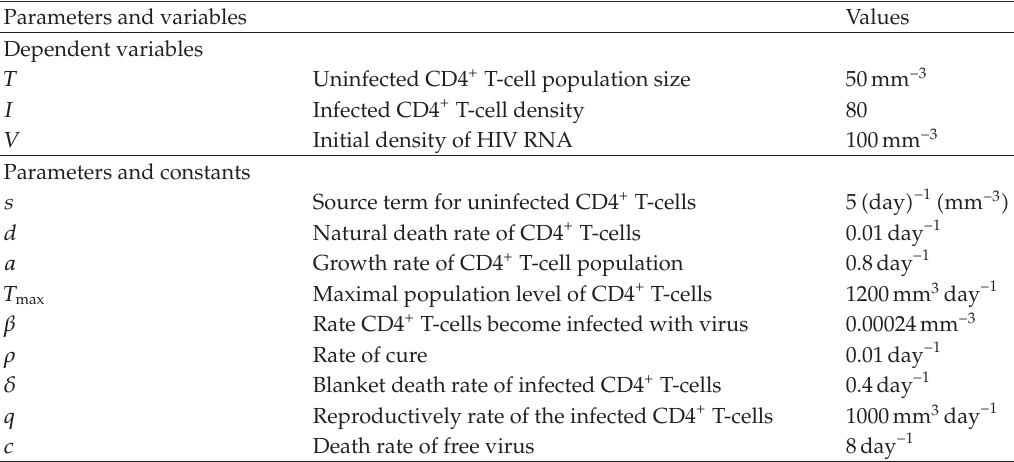
Table 1: Variables and parameters for viral